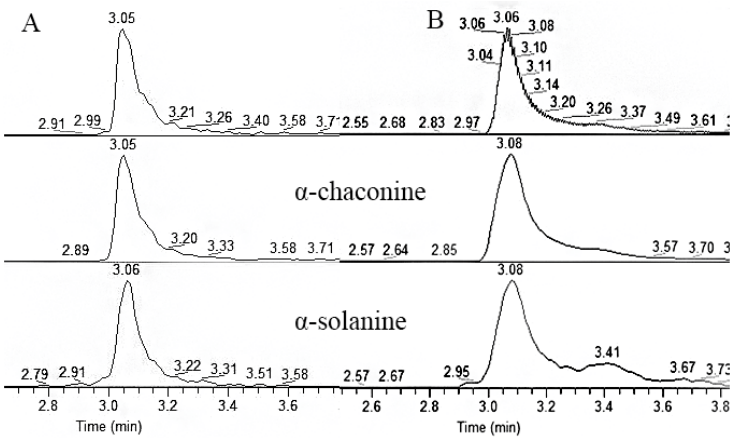
Figure 3. SGA concentrations in PTM tissue (( A ), newly-hatched PTM larvae; ( B ), puparium.).